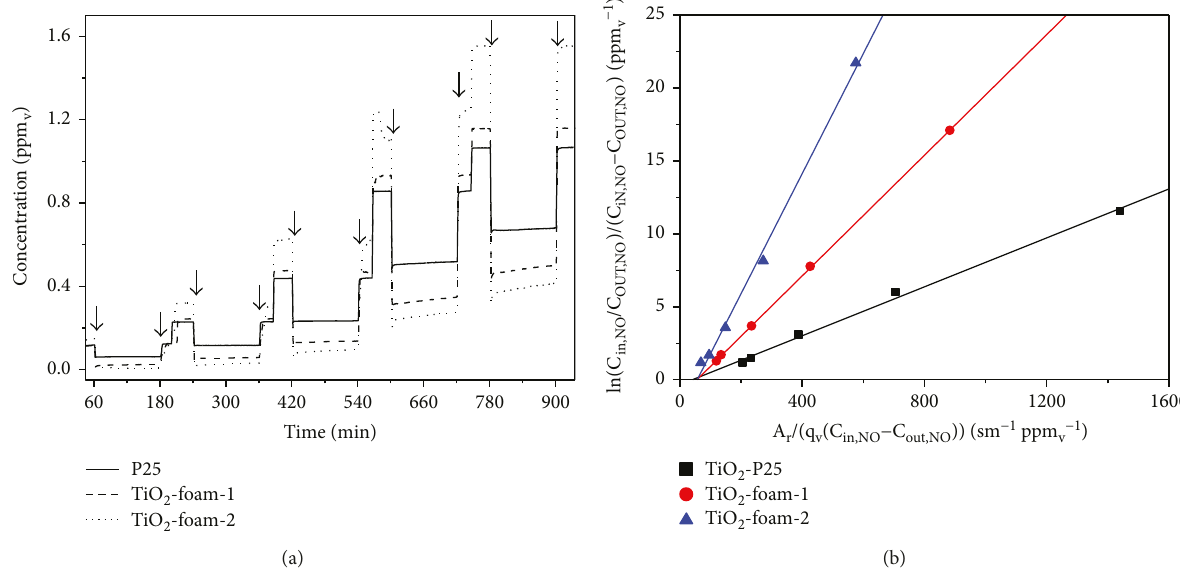
Figure 6: (a) Concentration changes of NO at the reactor outlet observed during three typical experimental run for a AEROXIDE P25, TiO foam-1 (with hexylic acid), and TiO the radiation source. (b) The data analysis according to